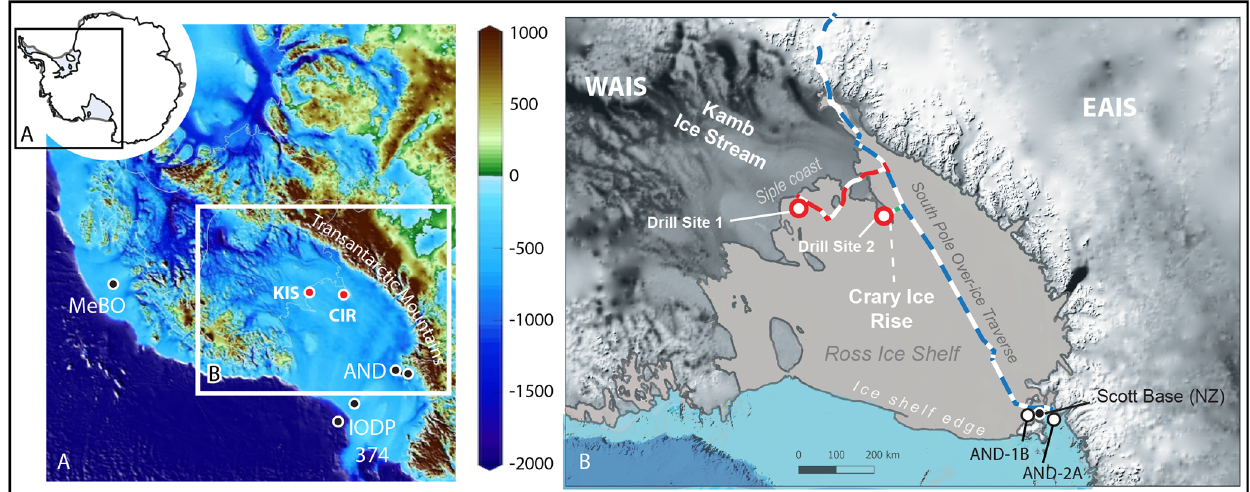
Figure 1. Proposed SWAIS 2C drill sites at Kamb Ice Stream (KIS) and Crary Ice Rise (CIR). (A) Topographic/bathymetric map across West Antarctica (color scale in meters). Other key drill sites include MeBO, ANDRILL (AND-1B and -2A), and IODP Exp. 374 sites (Fretwell et al., 2013). (B) Detail of the Ross Ice Shelf showing the South Pole Over-Ice Traverse and routes to drill sites 1 (KIS) and 2 (CIR). The new sites would anchor the southern end of a drill site transect deeply within West